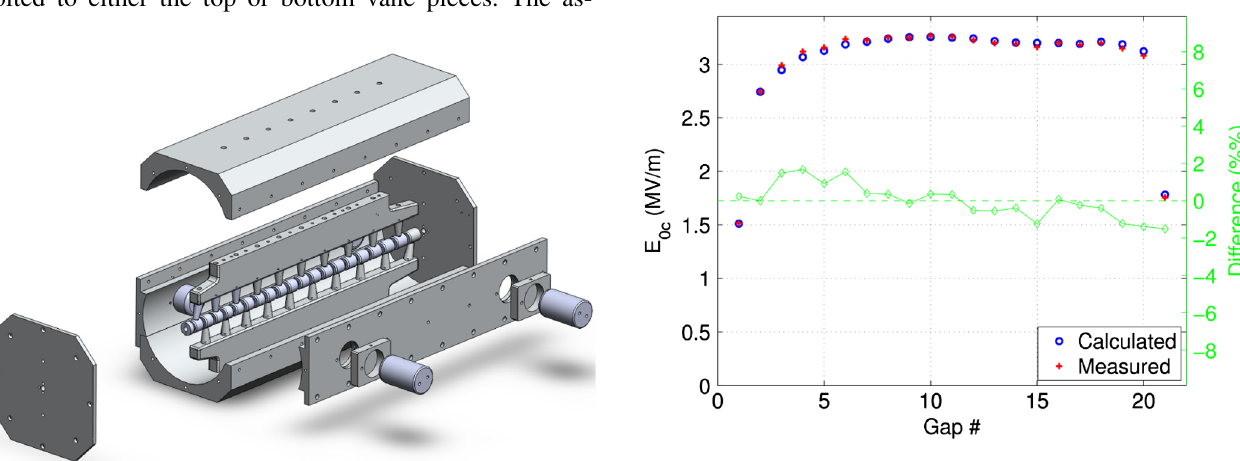
FIG. 22. A close-up view of the DTs installed on the bottom part of the IH1m cold model.